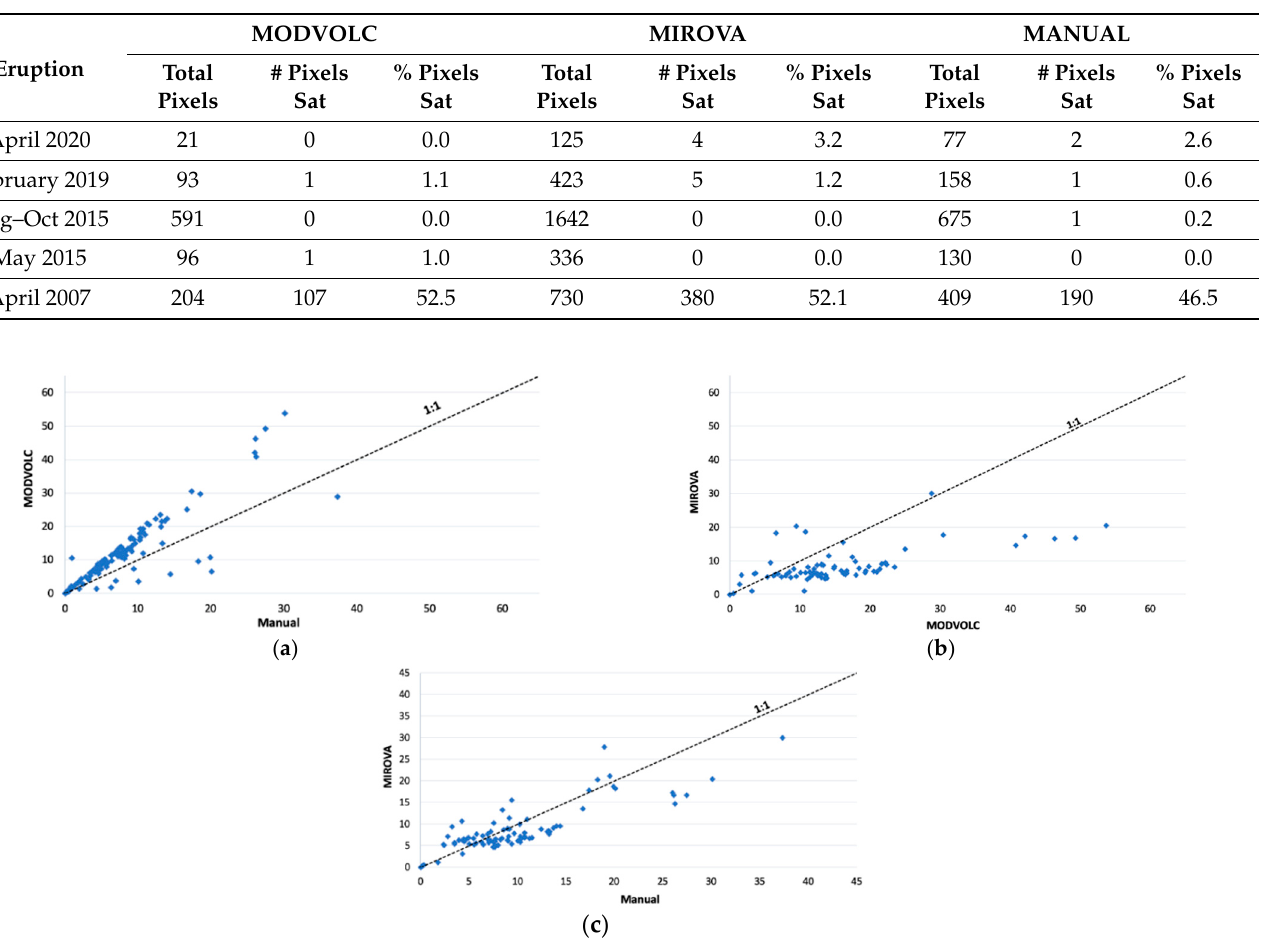
Table 3. Summary of the total pixels for each eruption counted by each method. Note that the MIROVA algorithm resampled MODIS images into 1 km equal area pixels (e.g., high zenith angle). Hence, for some cases, one original MODIS pixel may be divided into several “MODIS-MIROVA” pixels. That explains the differences in total pixels between MIROVA and the other approaches. “#/% pixels sat” = number/percentage of saturated pixel.